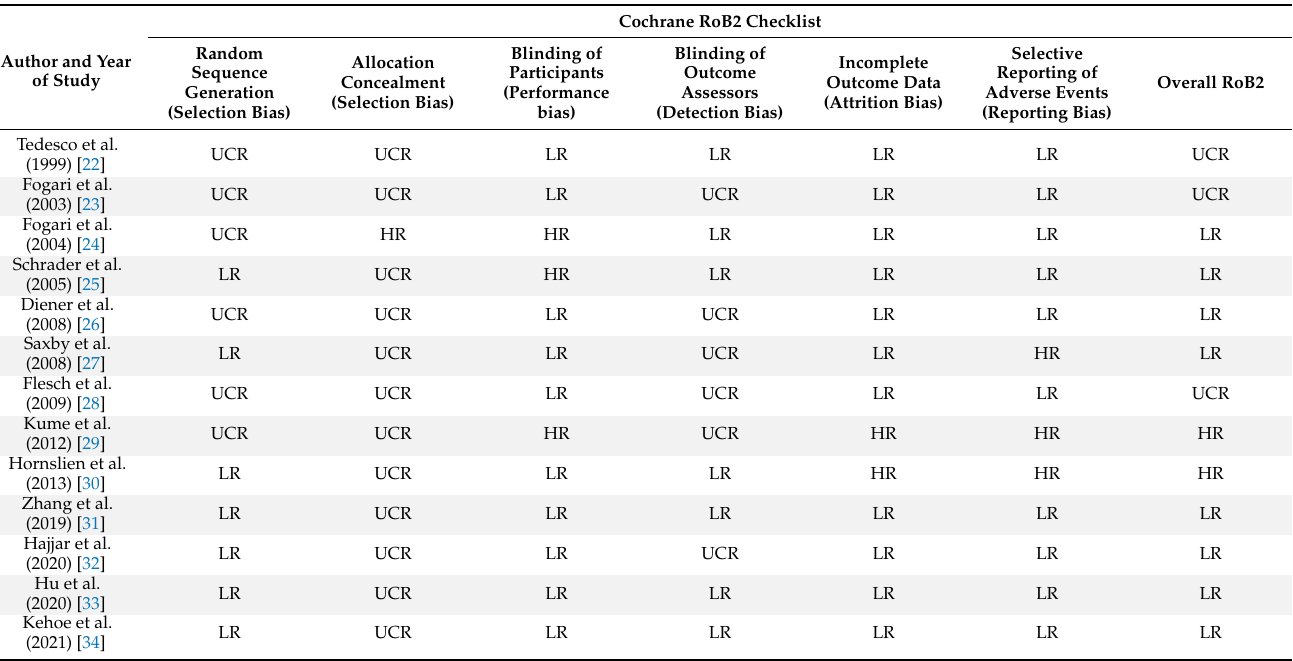
Table 7. The Cochrane RoB2 checklist [21], used to assess potential biases in the included randomised controlled